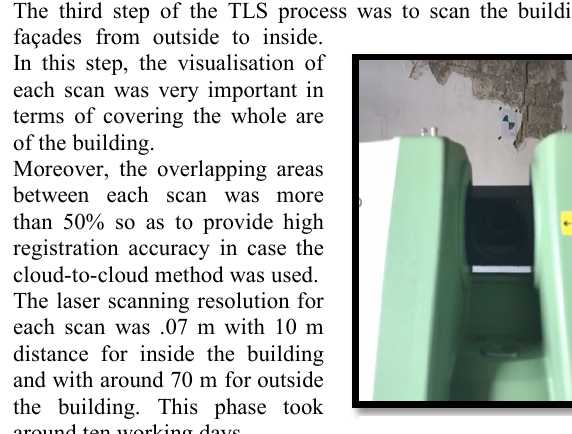
Figure 7: Identifying the target.